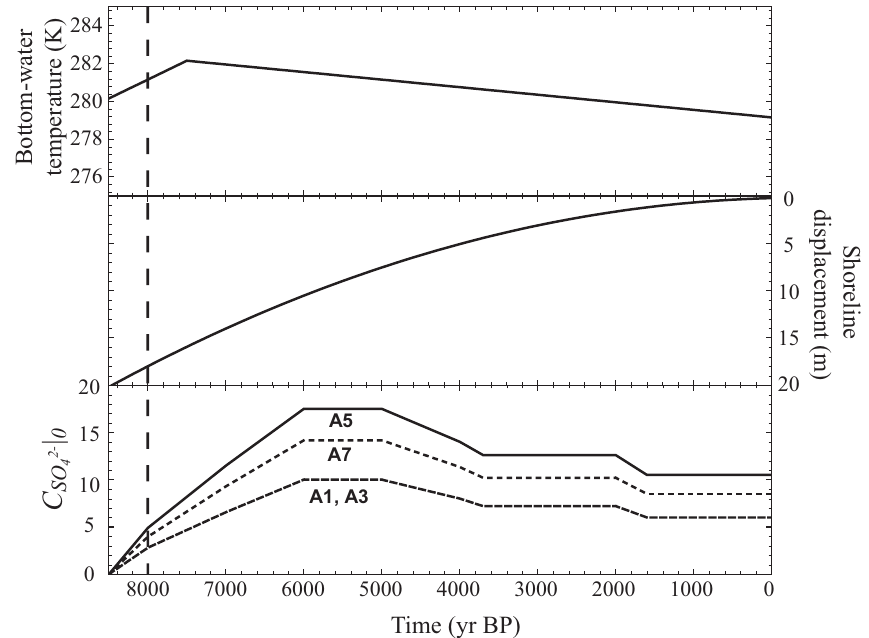
Fig. 3. Temporal variations in bottom-water temperature (top panel, adapted from Sepp¨a et al., 2005), in the relative shoreline displacement (e.g. the sea-level drop) with respect to modern-day levels (middle panel – adapted from Bennike and Jensen, 1998), and in the bottom-water sulphate concentration imposed for all 4 cores (bottom panel, adapted from Gustafsson and Westman, 2002) in Arkona Basin during the past 8.5kyr. Note that the temperature in the top panel represents the inter-annual signal over which a seasonal signal with a temperature amplitude of 4K was superimposed. The vertical dashed line represents the time (8kyr BP) when the Holocene organic-rich mud deposition